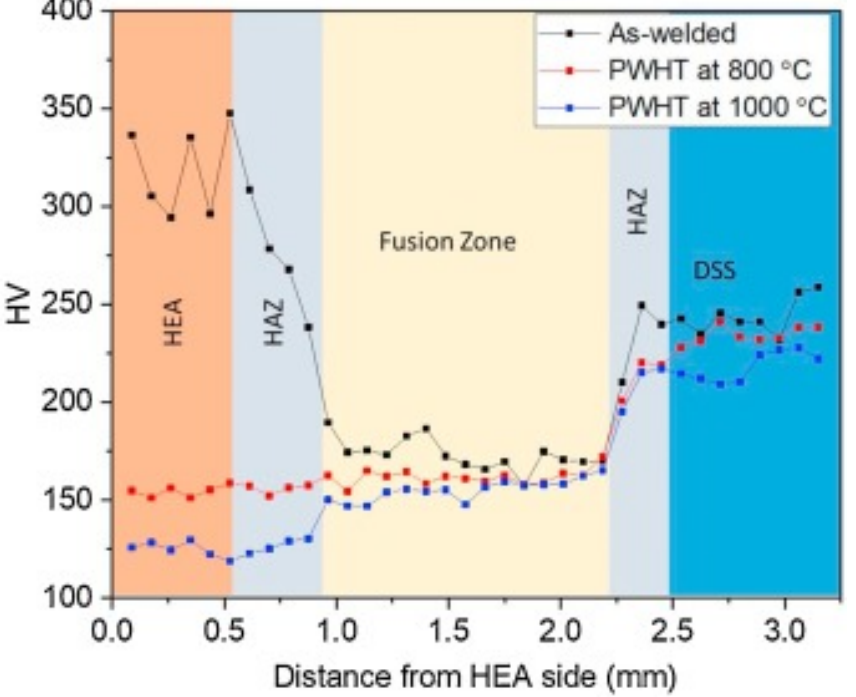
Figure 10 . Variation in m icrohardness of the as -weld is shown in the black line, PWHT at ( 800 °C Figure 10. Variation in microhardness of the as -weld is shown in the black line, PWHT at 800 ◦ C indicated in red line or (b) PWHT at 1000 °C is shown in the blue line. Reproduced with permission indicated in red line or PWHT at 1000 ◦ C is shown in the blue line. Reproduced with permission from [88]. Copyright Elsevier, 2021. from [88]. Copyright Elsevier,